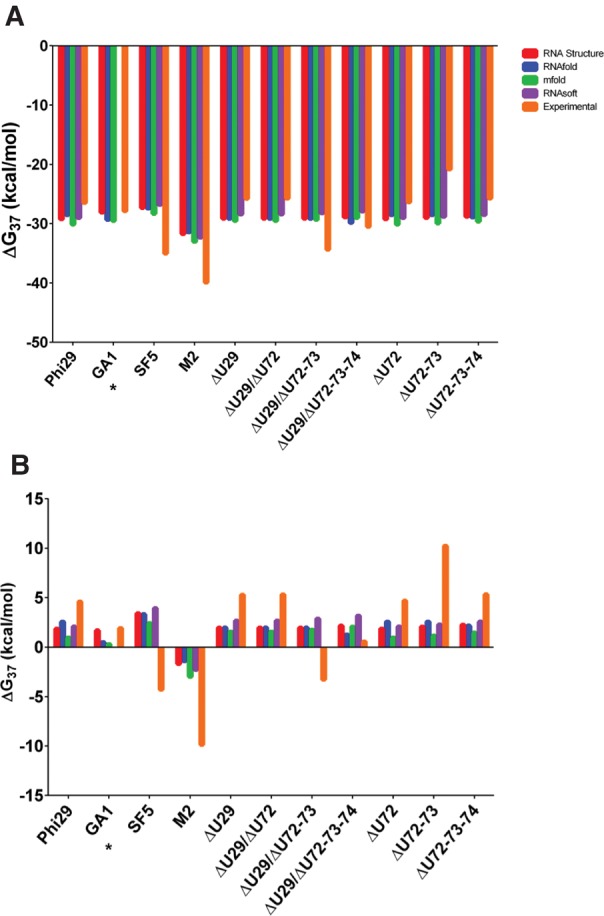
(A) Measured thermodynamic stabilities and secondary structure free-energy predictions for pRNA 3WJ constructs using RNA Structure (Mathews et al. 2004), RNAfold (Lorenz et al. 2011), mfold (Zuker 2003), and RNAsoft (Andronescu et al. 2003). (B) Calculated 3WJ nanomotif thermodynamic stabilities and secondary structure free-energy predictions using the same programs. *RNAsoft did not output a secondary structure free energy for the GA1 pRNA 3WJ due to computer run-time limitations.